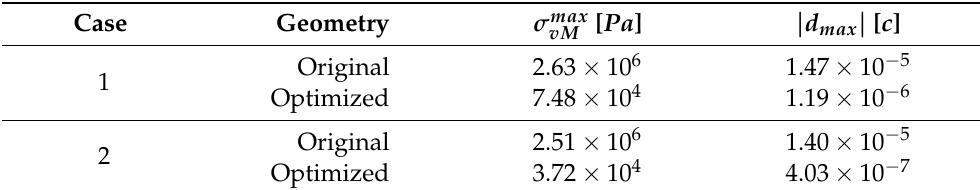
Figure 13. Pressure coefficient distribution comparison for case 2. Table 6. Structural parameters comparison between the aerodynamically optimized and the original airfoil’s geometries.